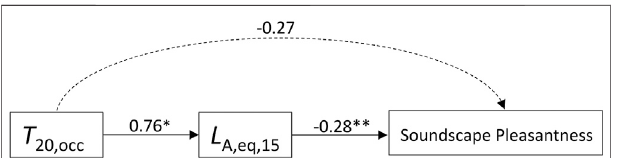
FIGURE 4 | Mediation analysis on acoustical parameters predicting soundscape pleasantness. Note: The estimates represent standardized regression coef fi cients β , and the asterisks indicate the signi fi cance of the respective effects, * p < 0.05, ** p < 0.01, as obtained by the SEM routine of the Lavaan Package in